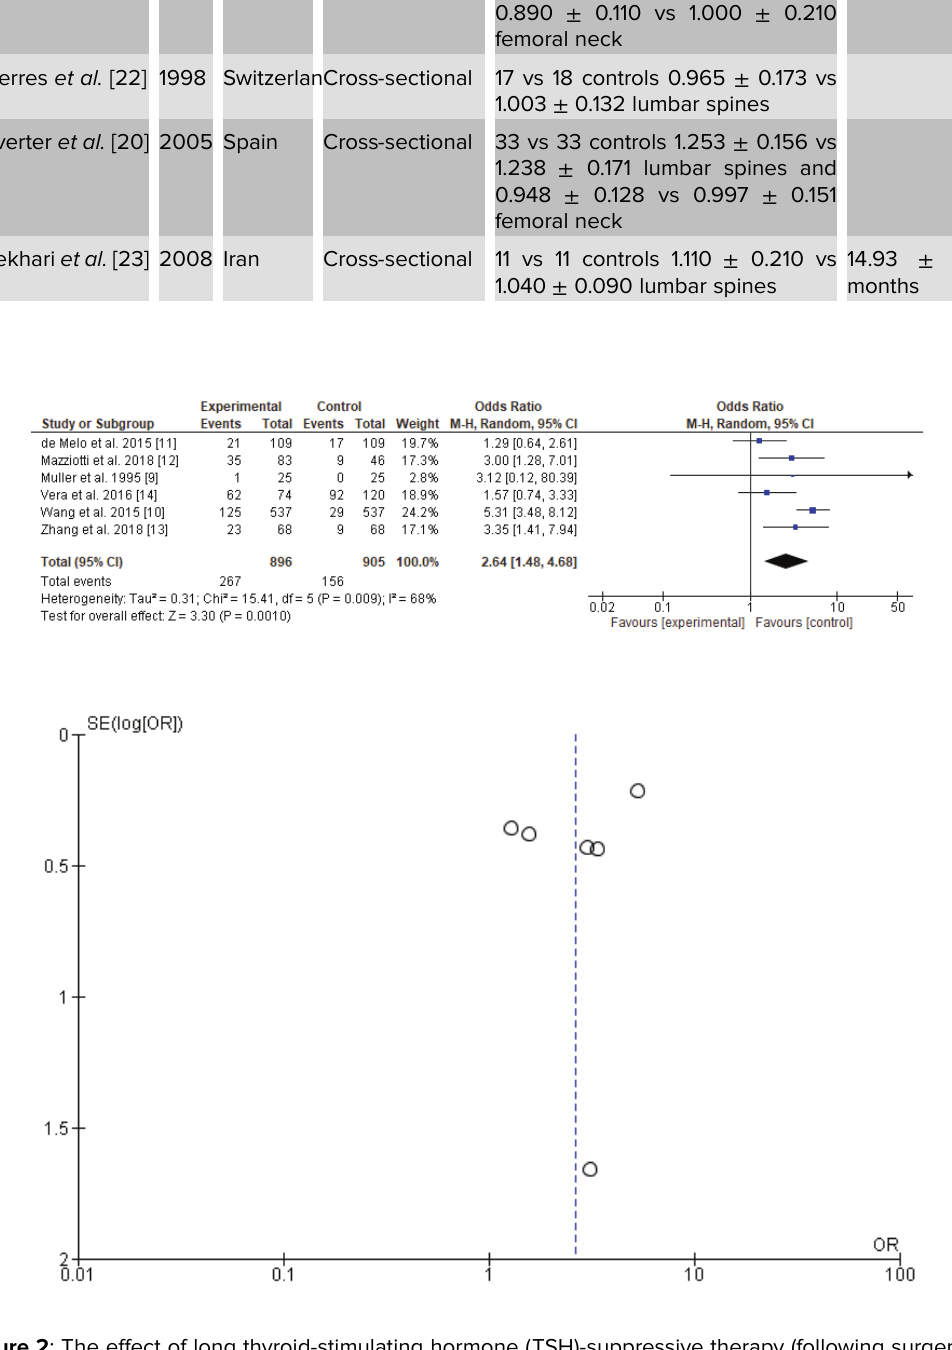
Figure 2 : The effect of long thyroid-stimulating hormone (TSH)-suppressive therapy (following surgery for differentiated thyroid carcinoma) on bone mineral density